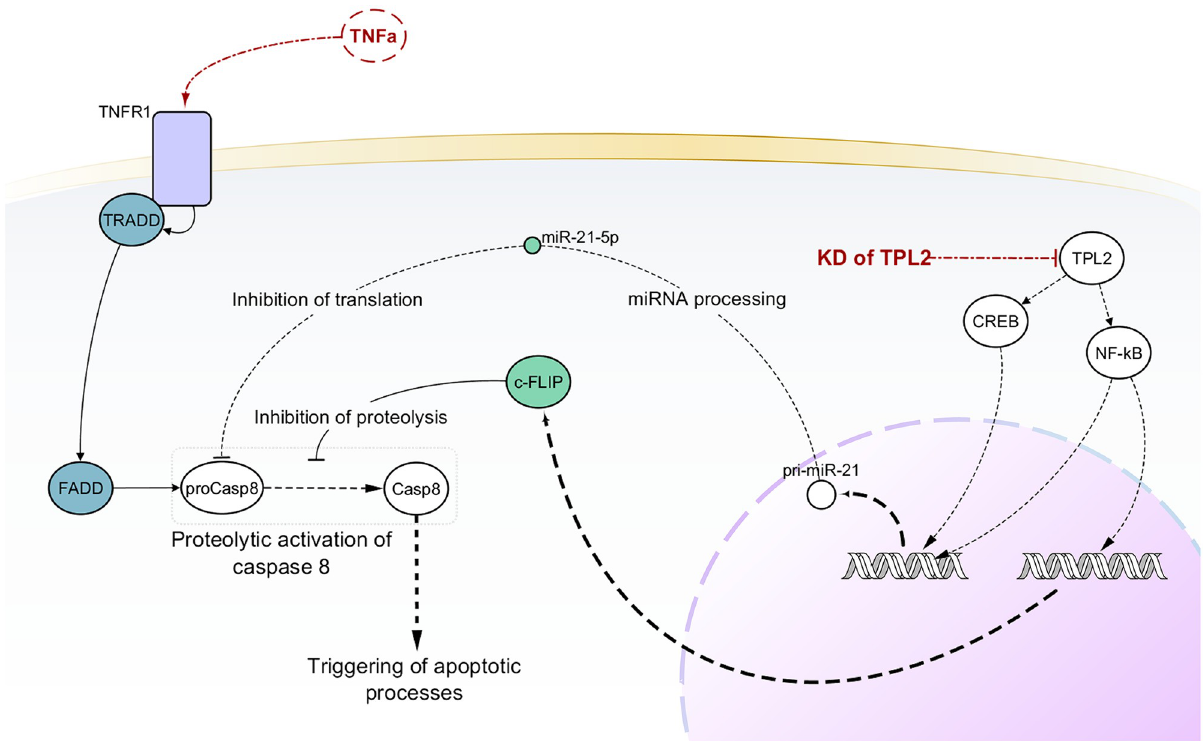
Fig 5. Generalized model showing molecular mechanisms underlying the TNF α /siTPL2-dependent synthetic lethality. Black solid edges represent direct interaction between first neighbor nodes. Dashed edges represent indirect interactions between nodes. Red dot-dashed edges evidence scientifically validated interactions considered for PHENSIM